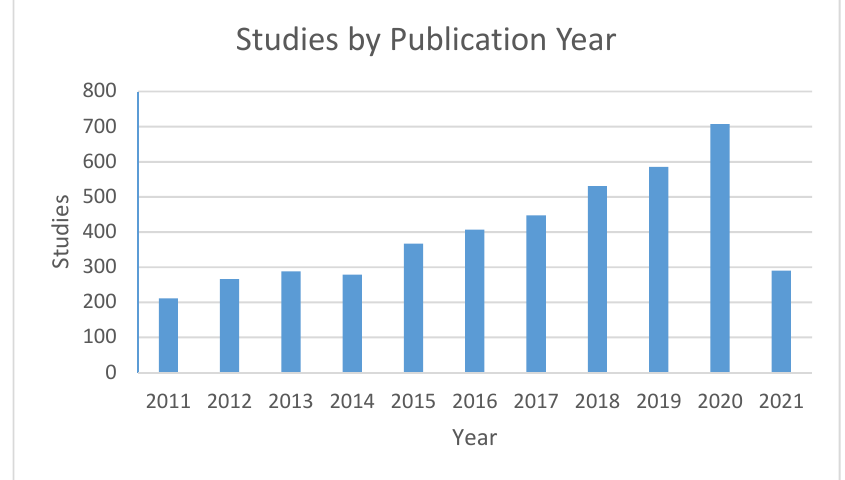
Figure 2. Studies published by year.